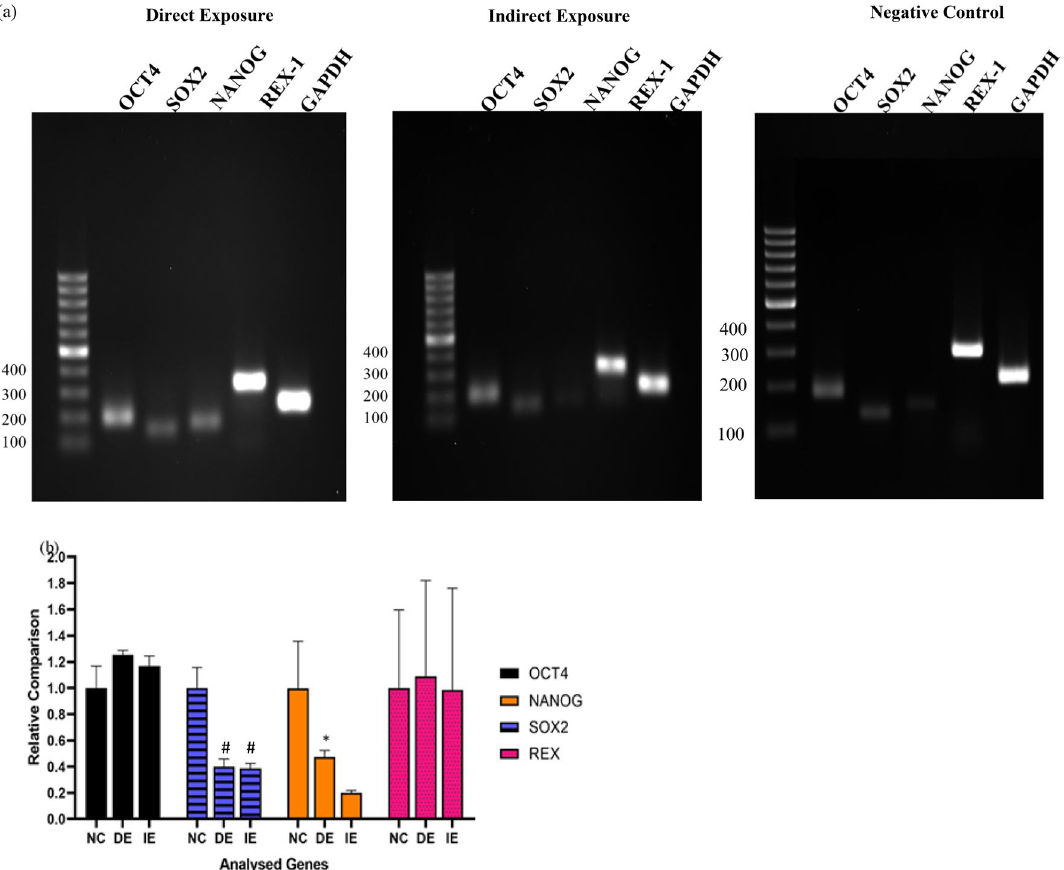
Figure 5. Gene expression of pluripotent-associated markers ( OCT4, SOX2, NANOG and REX-1 ) in MF exposed hUC-MSCs. ( a ) The RT-PCR product on agarose gel-electrophoresis performed to determine the expression intensity of the markers mainly expressed in undifferentiated MSCs. ( b ) Fold change showing the upregulation of OCT4 in both the DE and IE groups with expression levels higher in the DE group relative to the IE group. The SOX2 gene was significantly downregulated in the DE and IE groups, while NANOG was significantly upregulated in DE (2.73-fold change) relative to IE